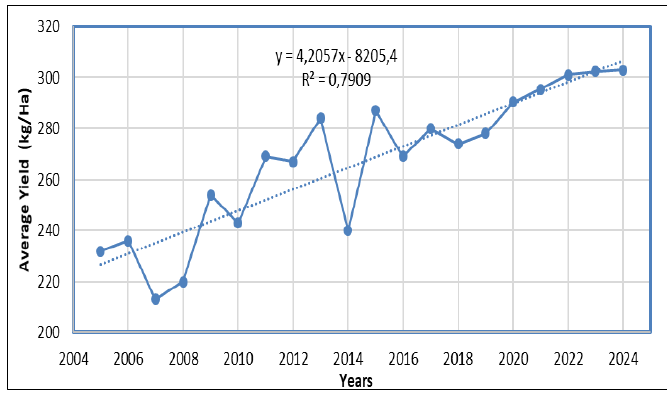
Figure 5: The average yield of wheat in Turkey between the years 2005 to